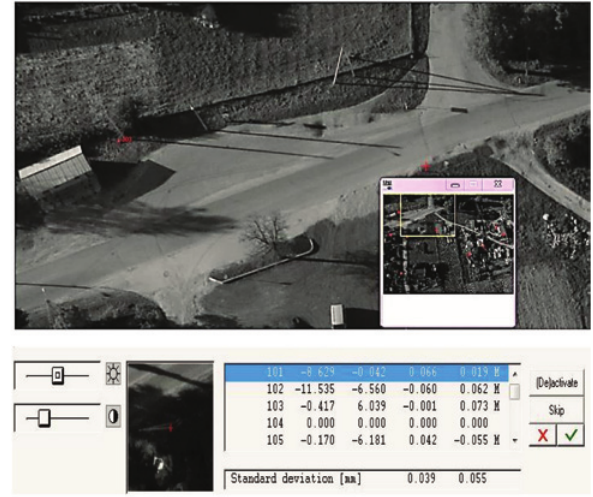
Fig. 7. Fragment of left image exterior orientation results